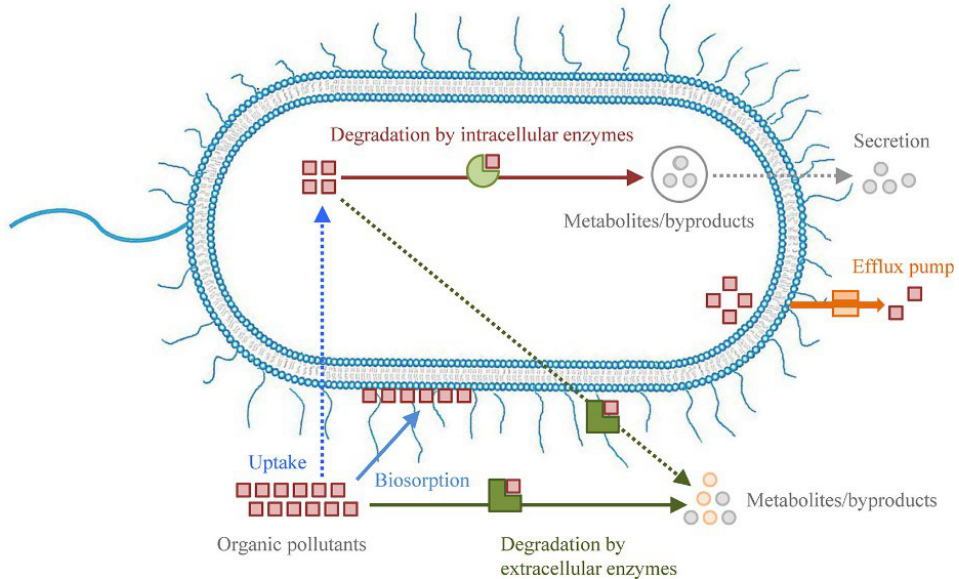
Figure 6. Possible biological interactions between cells and organic pollutants. Reprinted (adapted) with permission from [51]. Copyright (2019) American Chemical Society.